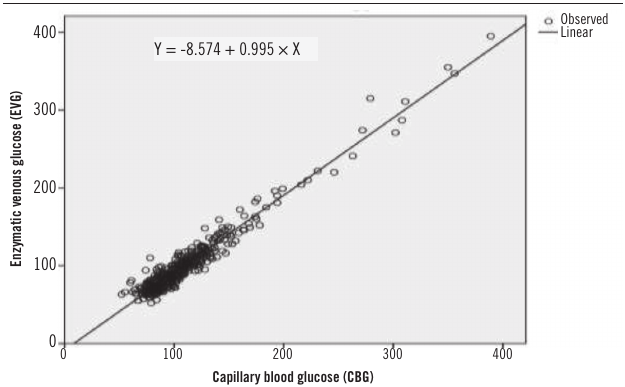
figure – Analysis of linear